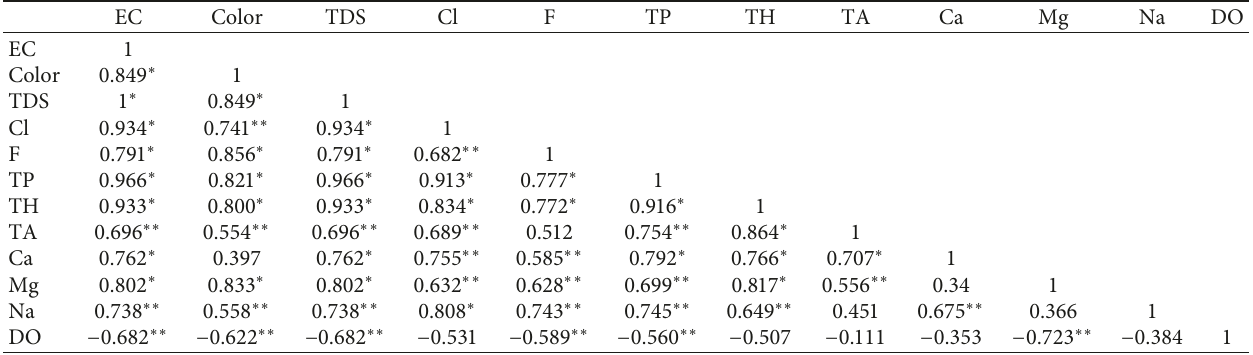
Table 3: Correlation matrix of twelve different physicochemical parameters.